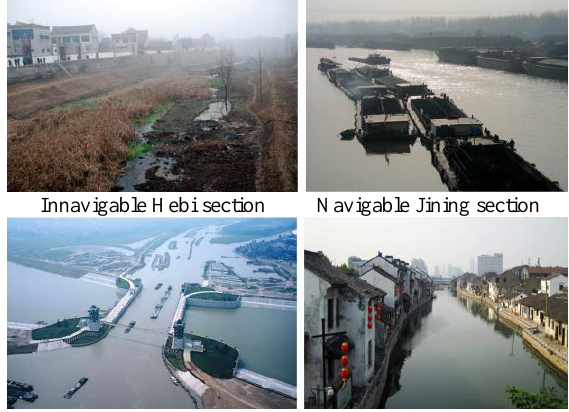
Figure 2. Status of different canal